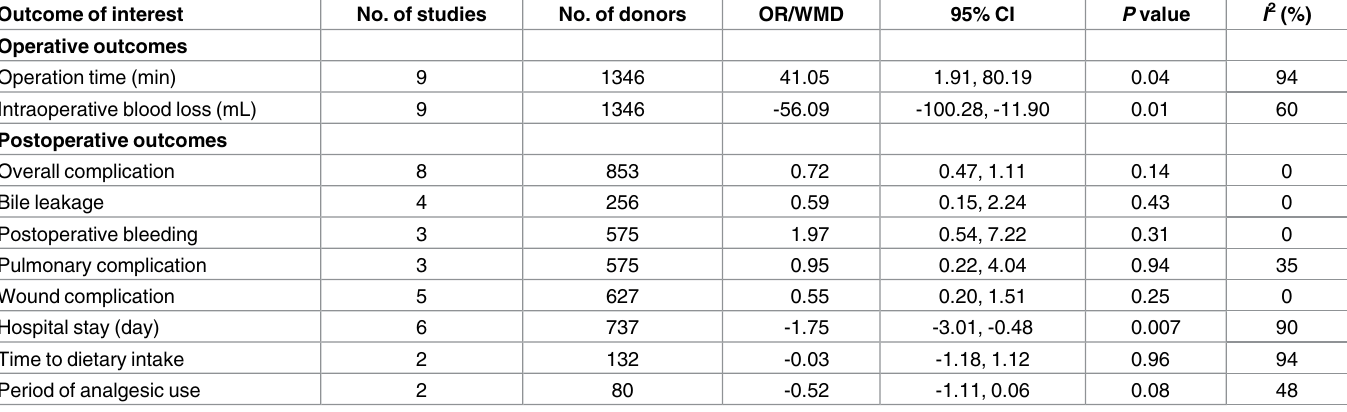
Table 2. Results of meta-analysis comparing laparoscopic versus open living donor